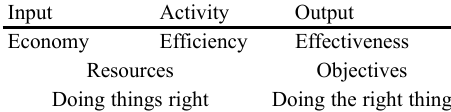
The relationship between economy, efficiency and